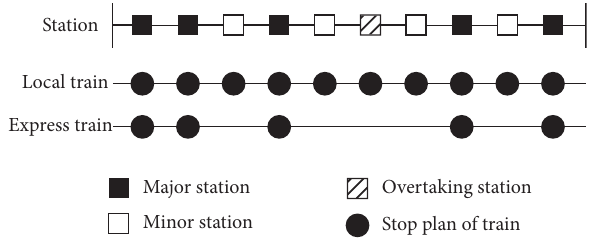
Figure 1: Illustration for express/local